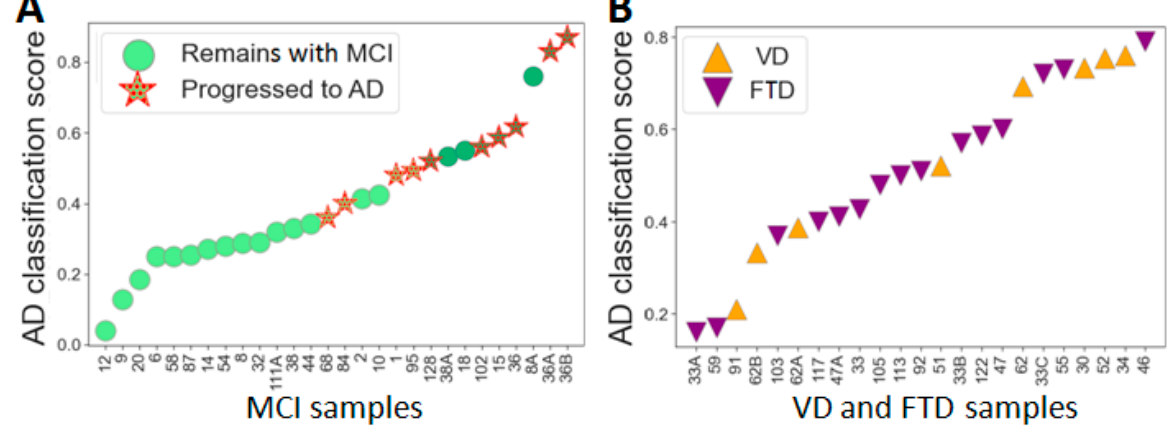
Figure 5. The distribution of MCI, VD and FTD patients according to the probability of AD development using the RF-31 classifier. ( A ) Distribution of MCI patient samples with a known three-year prognosis (samples of MCI-nc patients with <3 years of observation are excluded). ( B ) The distribution of the VD and FTD samples.